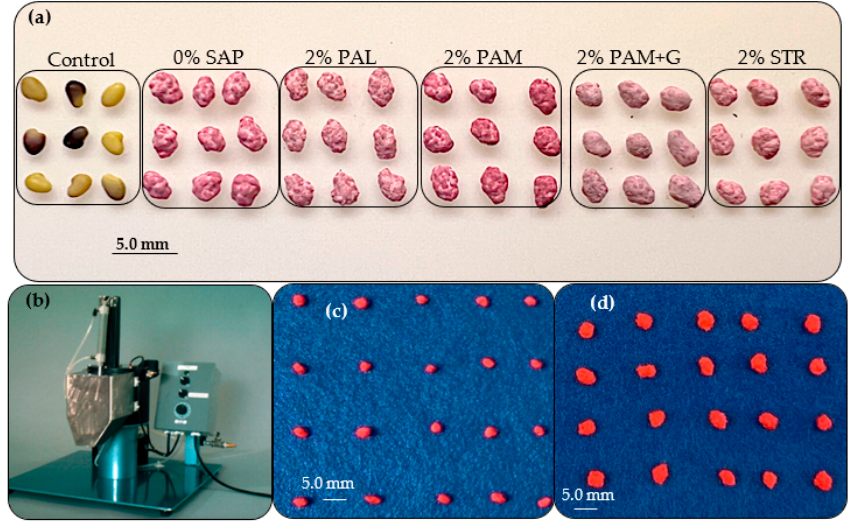
Figure 4. ( a ) Non-treated control and coated red clover ( Trifolium pratense L.) seeds used in this study (Table 1). ( b ) Rotary pan coater-R6. Comparison of seeds coated with ( c ) no SAP (0% SAP) and ( d ) 2% PAL coating (PAL coating held moisture around seeds).